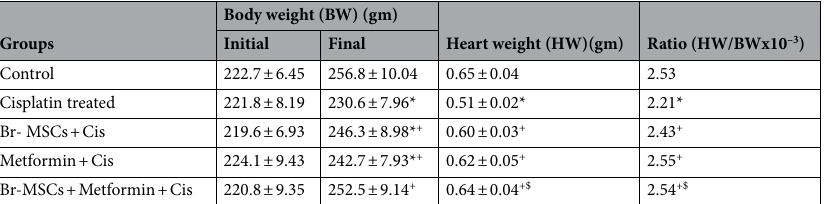
Table 1. Effect of Br-MSCs, metformin and their combination on body weight (BW), heart weight (HW), and heart weight/body weight ratio (HW/BW) in adult male albino rats with cisplatin-induced cardiotoxicity. Cis cisplatin. Br‑MSCs Breast Milk mesenchymal stem cells. *P < 0.05 when compared with control, + P < 0.05 when compared with cisplatin. $ P < 0.05 when compared with Br-MSCs + cisplatin. Statistical analysis was done by using one way ANOVA test. Values were expressed as (mean ±